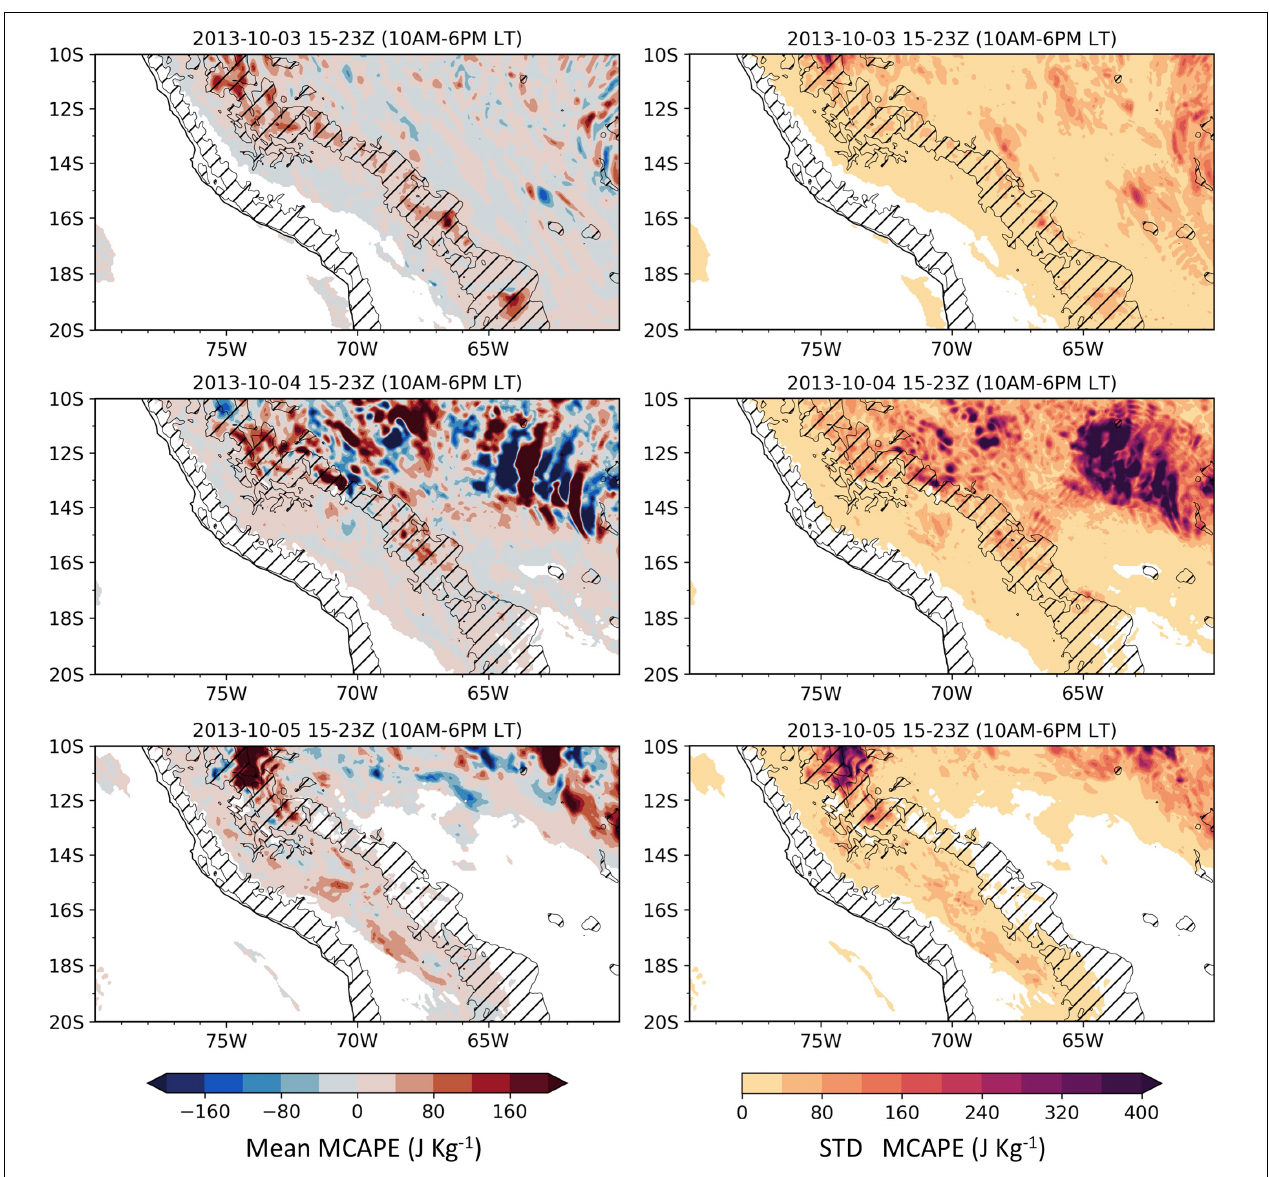
FIGURE 6 | Mean (left column) and standard deviation (right column) of differences (CAI – CAIS) in MCAPE between the control and the modified land-use simulation from the WRF simulation (D02, 6 km) for the CAI case. The mean and standard deviation are calculated for daytime that is between 15Z and 23Z (10 a.m. to 6 p.m. LT). The hashed lines show the elevations between 500 and 3,500 m. white background-not